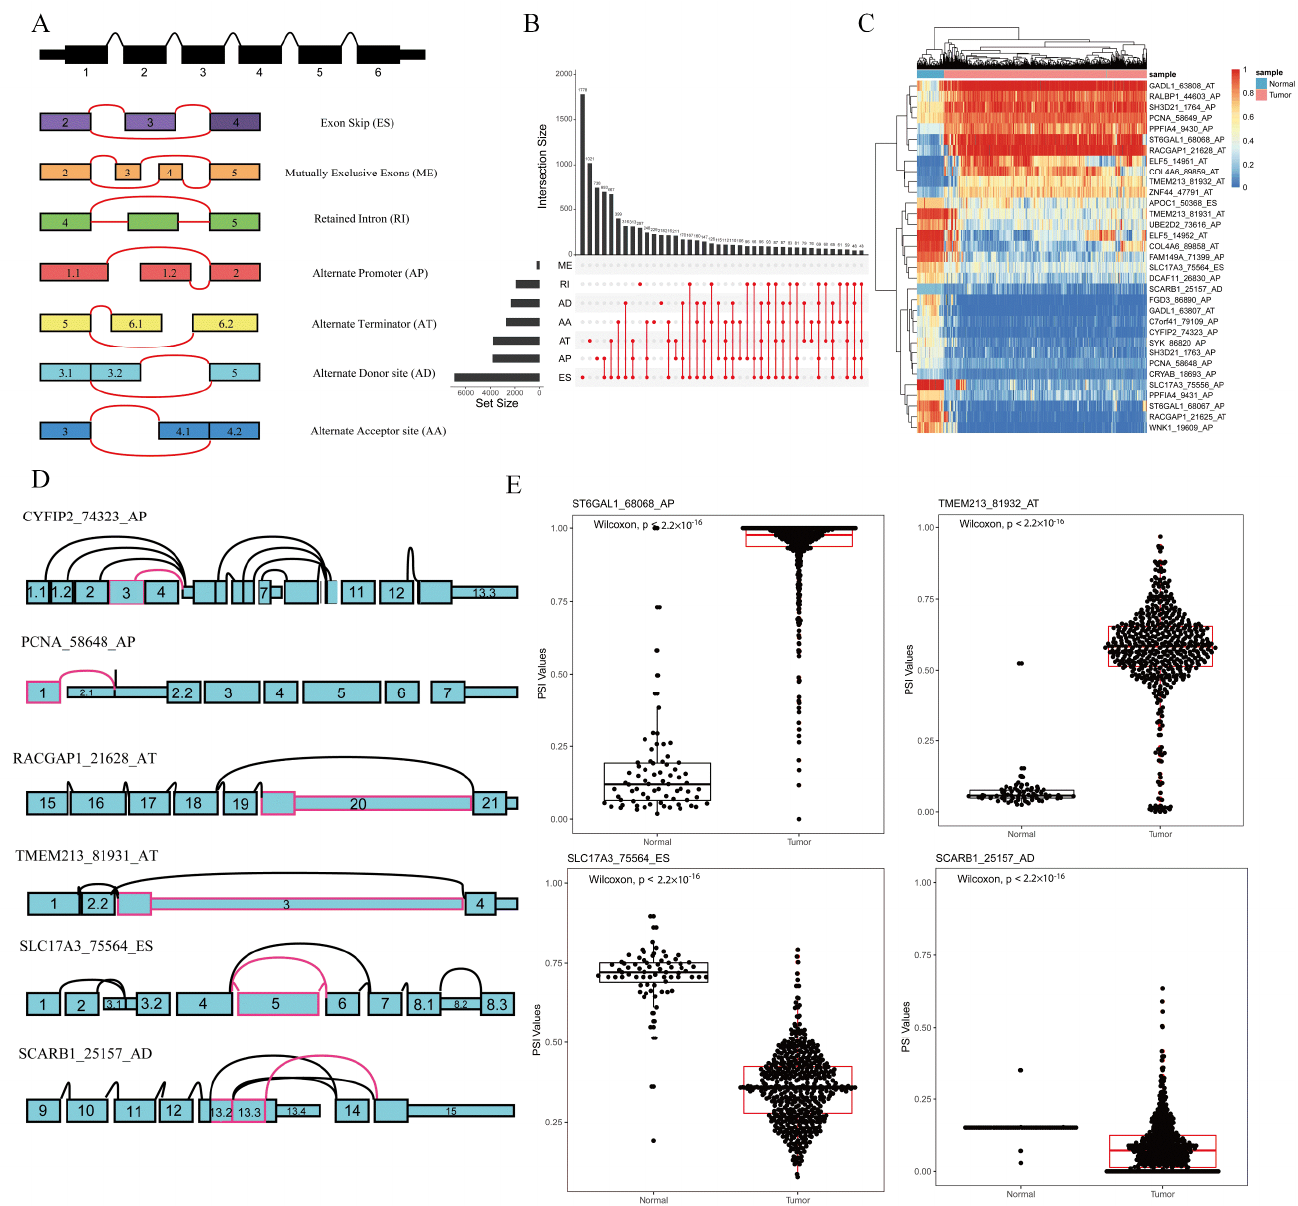
Figure 1. Overview of AS events profiling in KIRC. ( A ) Seven types of AS events: exon skip (ES), mutually exclusive exons (ME), retained intron (RI), alternate promoter (AP), alternate terminator (AT), alternate donor site (AD), and alternate acceptor site (AA). ( B ) UpSet plot of interactions between the seven types of detected AS events (n = 46,415) in KIRC. ( C ) Heat map of significant ASEs (n = 33). Horizontal axis shows clustering information of samples (normal or tumor); left longitudinal axis shows clustering information of ASEs. Gradual change in color from green to red represents PSI value of ASEs altered from low to high. ( D ) Splice graphs of some representative ASEs. Exons were drawn to scale, and connecting arcs represent splice paths. ( E ) Boxplots of four differentially expressed ASEs showing different expressions of AS events between KIRC and normal samples. Wilcoxon test was used for data comparison.